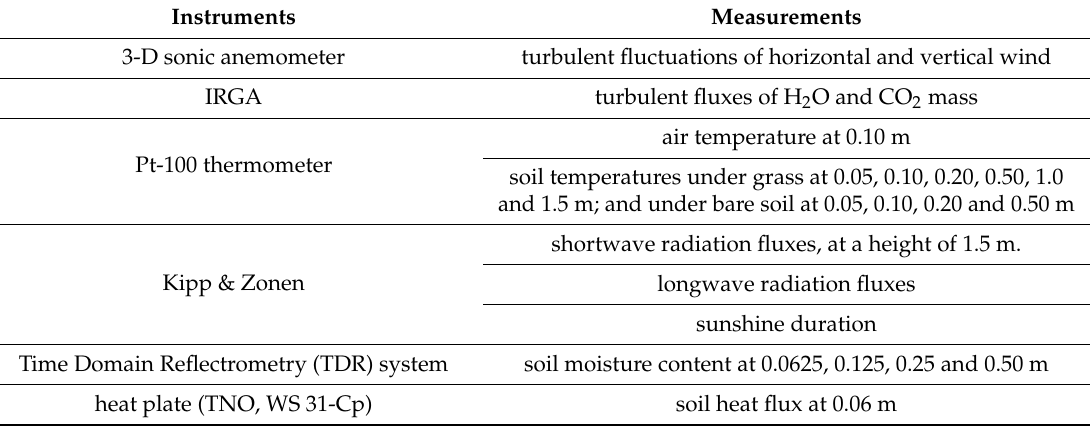
Instrumentation for the EC system and automated weather station at the research site